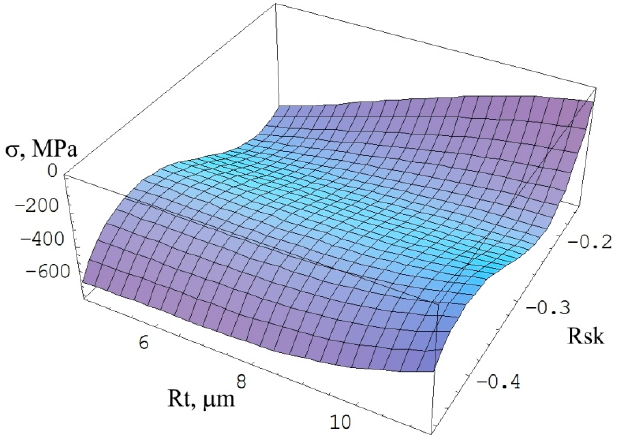
Figure 8. Effect of Rt and Rsk parameters on the values of compressive stresses.